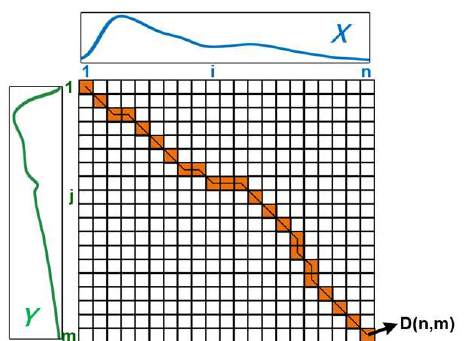
Figure 6. Dynamic time warping.